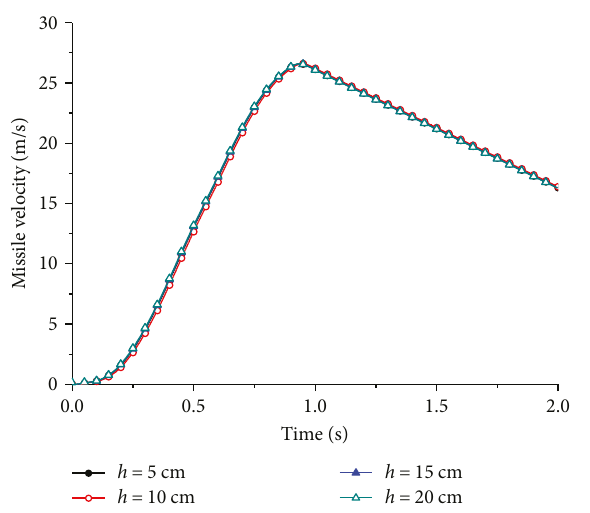
Figure 15: Missile velocity curves of di ff erent surface thicknesses. Table 2: The e ff ect of elastic modulus on velocity. Surface thicknesses (cm)